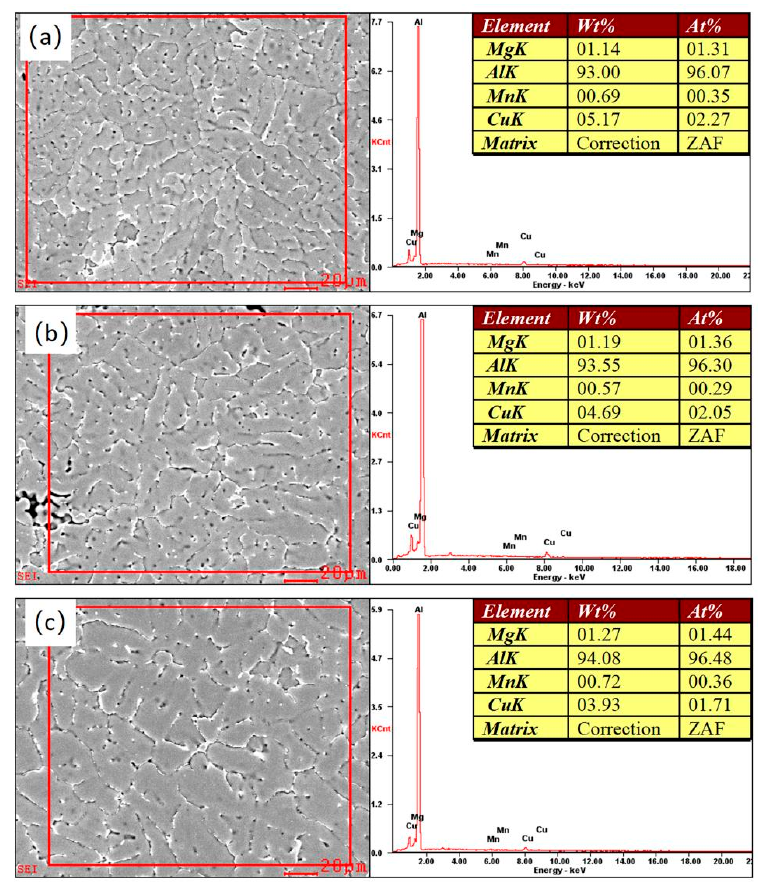
Figure 8. Welded center EDS: ( a ) 90 A; ( b ) 105 A; and ( c ) 120